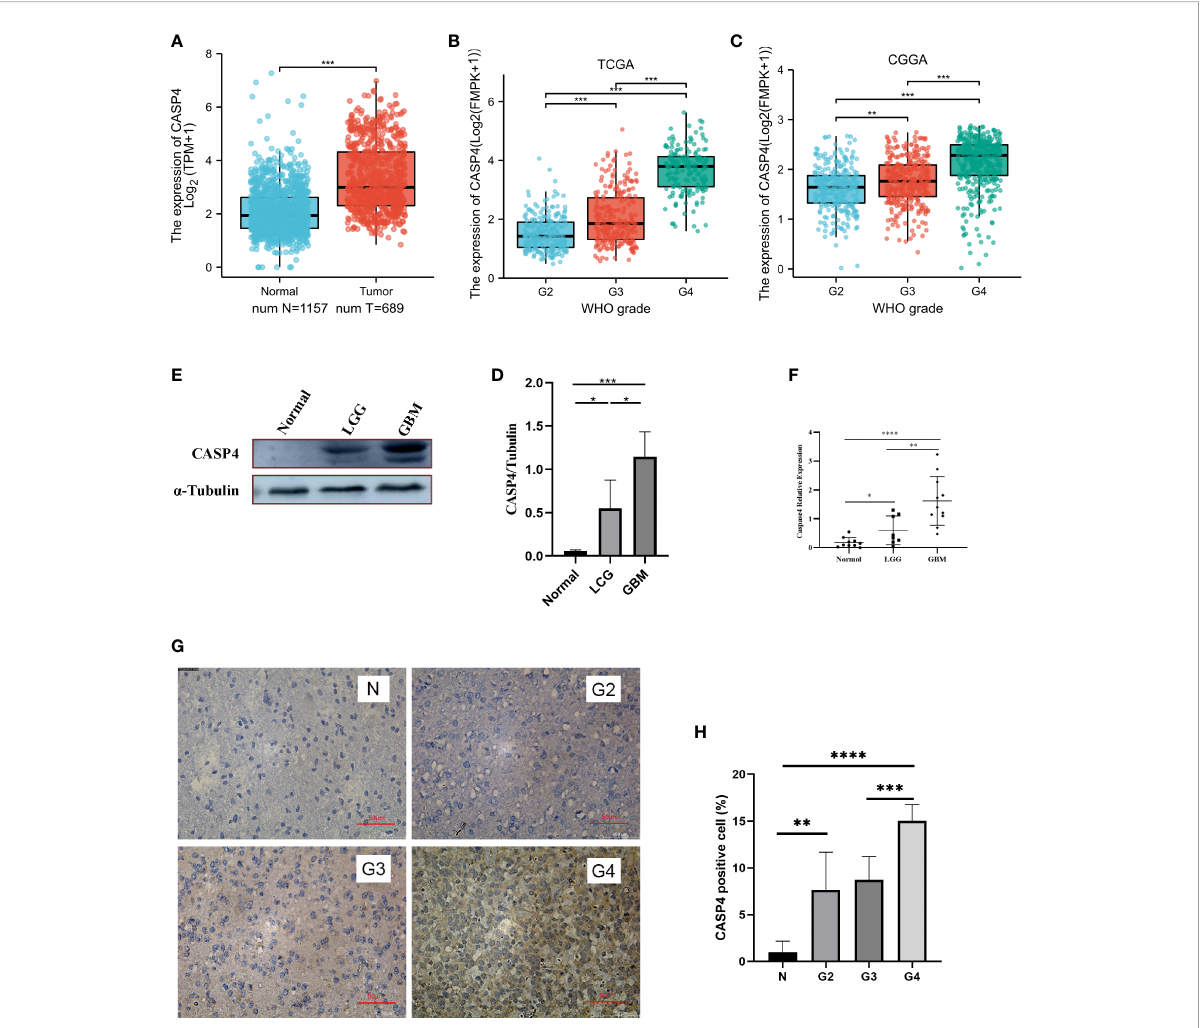
FIGURE 1 Expression patterns of CASP4 in gliomas. (A) Differential expression of CASP4 in different disease states (malignant or benign). The mRNA expression of CASP4 is markedly higher in 689 gliomas in The Cancer Genome Atlas (TCGA) database than in 1,157 normal tissues in the GETx. (B, C) Differential expression of CASP4 in different WHO grades. (B) TCGA database. (C) Chinese Glioma Genome Atlas database. CASP4 expression is signi fi cantly different from WHO G2 to G4, and the expression increased as the grade increased. (D – H) CASP4 expression at the mRNA and protein levels is veri fi ed using (D,E) western blot, (F) qRT-PCR, and (G,H) immunohistochemical staining (10 × 20). The results show that there is no signi fi cant difference between them (* P < 0.05, ** P < 0.01, *** P < 0.001, **** P < 0.0001). LGG, low-grade glioma; GBM,